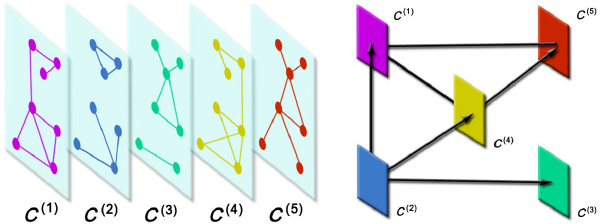
FIG. 1. Schematic of a multilayer network. When studying ordinary networks, one represents the interaction of entities (i.e., nodes) using an adjacency matrix, which encodes the intensity of each pairwise interrelationship. However, as shown in the left panel, entities can interact in different ways (e.g., depending on the environment in which they are embedded). In this panel, each layer of a multilayer network corresponds to a different type of interaction (e.g., social relationships, business collaborations, etc.) and is represented by a different adjacency matrix. As shown in the right panel, the layers can also be interconnected. One thereby obtains a new type of relationship, which complicates the description of networked